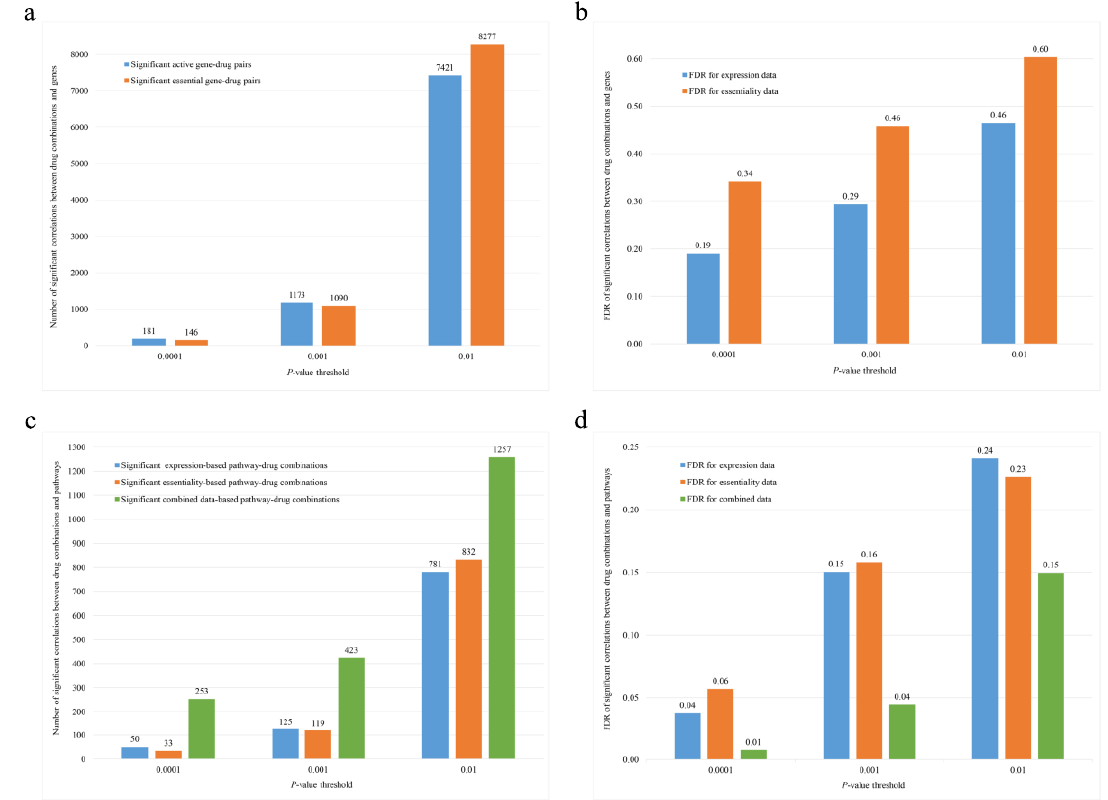
Figure 1. Comparison of significant correlations between drug pairs and genes and drug pairs and pathways under di ff erent thresholds. ( a , b ) Number and false discovery rate (FDR) of significant correlation between drug pairs and genes. ( c , d ) Number and FDR of significant correlation between drug pairs and pathways.